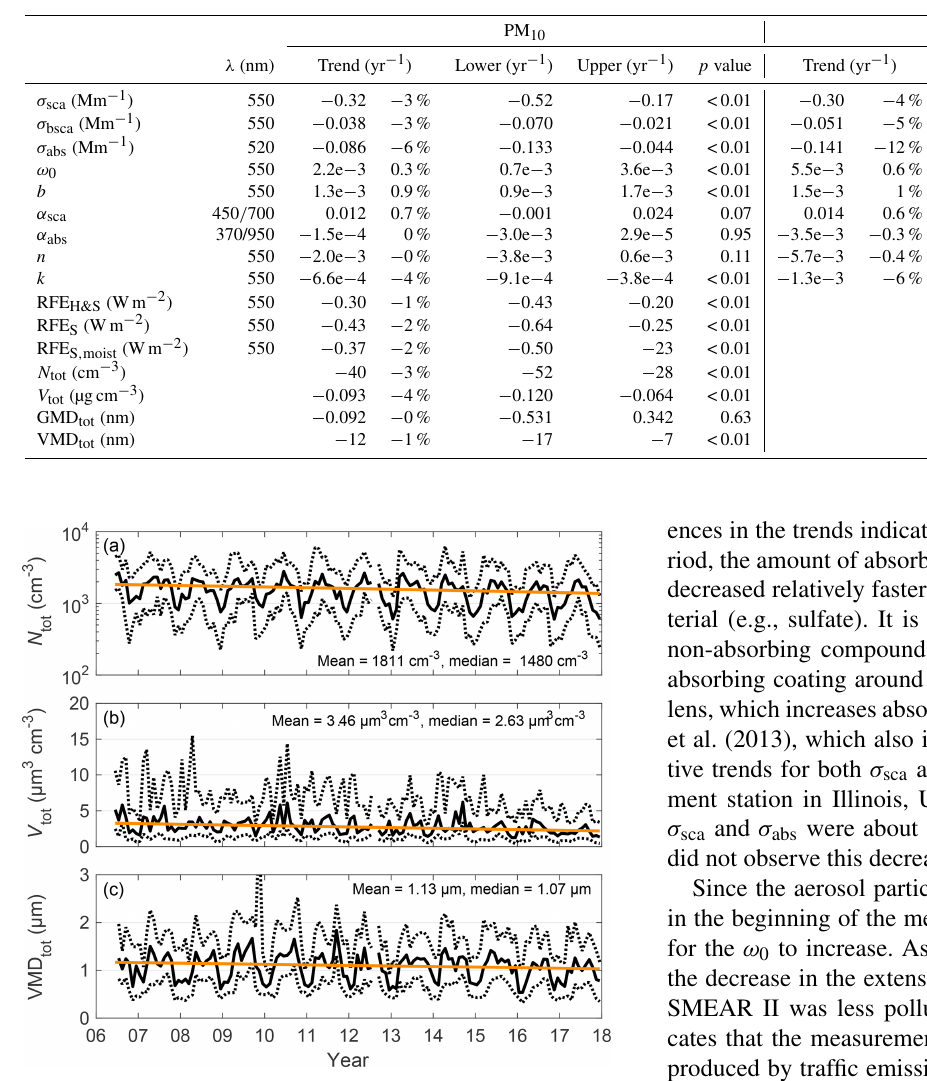
Table 3. Slopes of the trends (in absolute values and in estimated percentages per year) and their statistical significance. The lower and upper limits in the 95% confidence interval for different optical properties are also shown. The trend in the percentage was determined by comparing the slope of the trend with the overall median of the data.